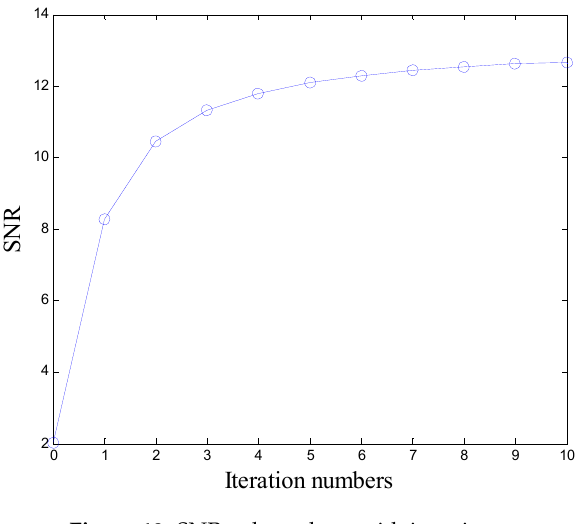
Figure 18. SNR values along with iterations. Appl. Sci. 2019 , 8 , x FOR PEER REVIEW